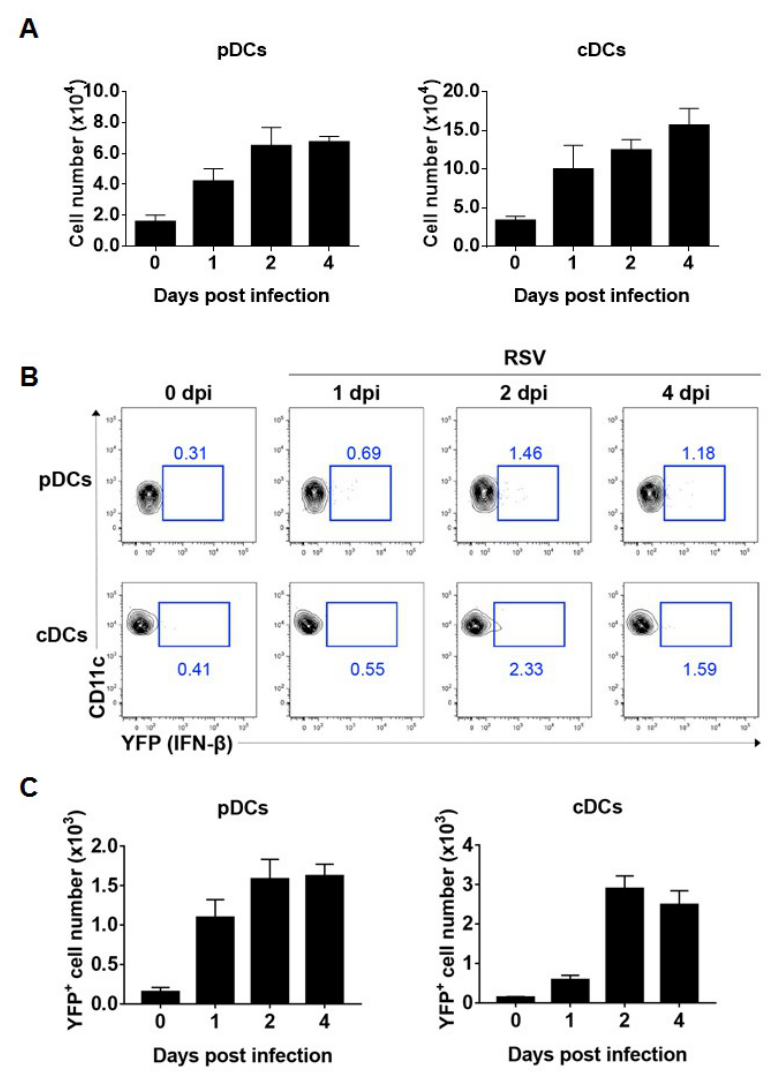
Figure 2. cDCs and pDCs in the lung can produce interferon-β during RSV infection. ( A – C ) YFP reporter (WT) mice were infected intranasally with 1.0 × 10 7 pfu RSV. After the indicated number of days post-infection, lung cells were isolated from mice and analyzed for interferon- β expression by flow cytometry. ( A ) The absolute number of lung pDCs and cDCs per lung was calculated. ( B , C ) Representative results are displayed as the number of YFP + cells per lung. The results are representative of three independent